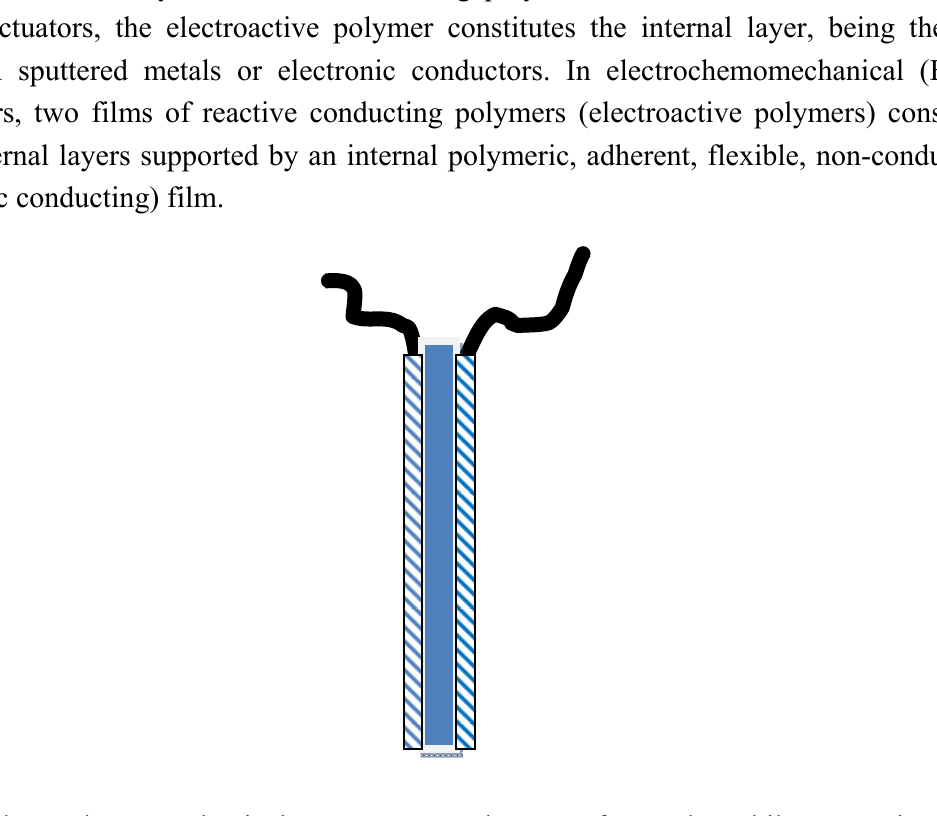
Figure 11. Three-layer structure for bending polymeric actuators. In